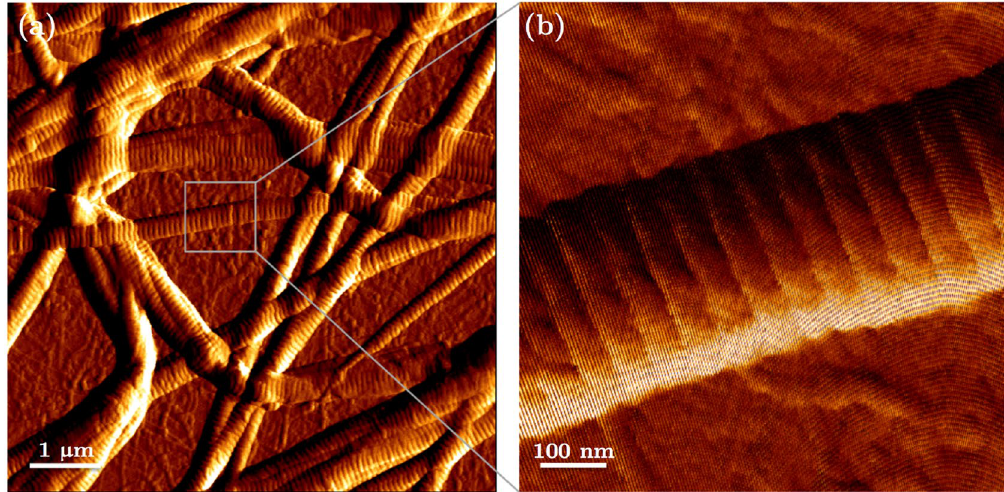
Figure 2. ( a ) Image of a network of collagen type I fibrils obtained with AFM; ( b ) AFM image of one single collagen type I fibril.